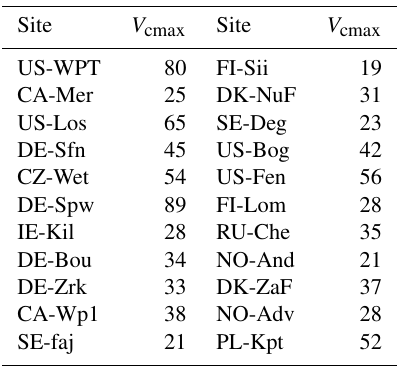
Table 3. Optimized V cmax (µmolm − 2 s − 1 ) at each